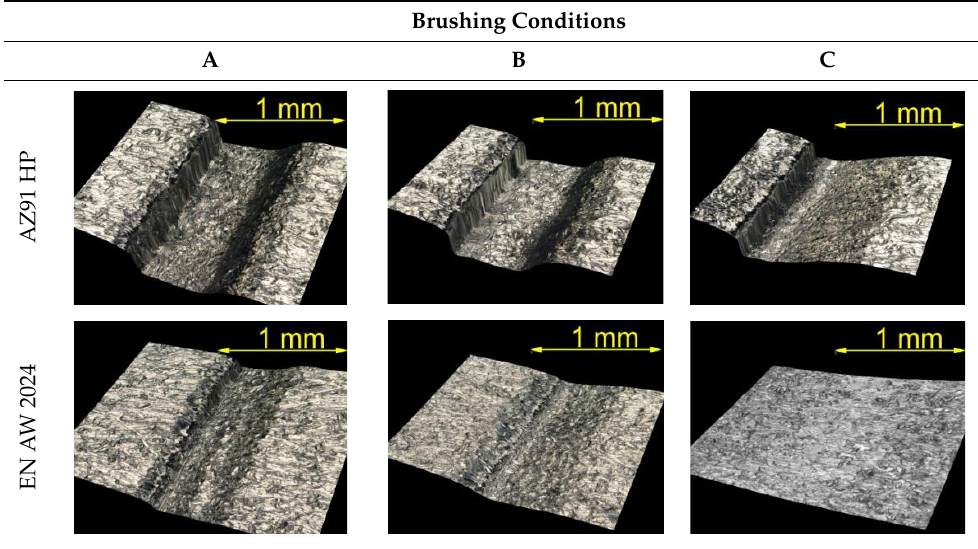
Table 5. View of defects after the brushing process (for a defect generator load of 15 N).